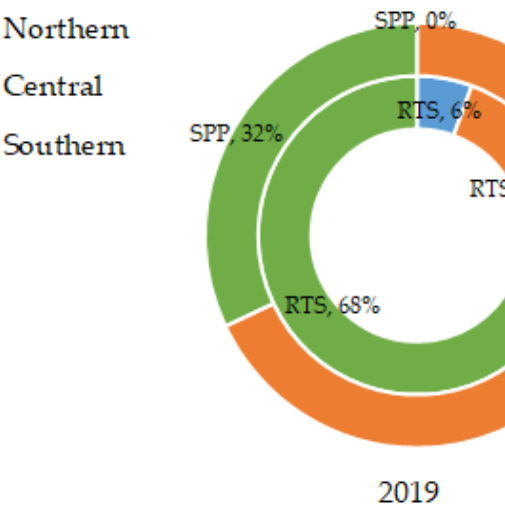
Figure 9. Share of total installed capacity of new SPP and RTS in 2019 and 2020. (Adapted from Refs. [43,44,64,65]).